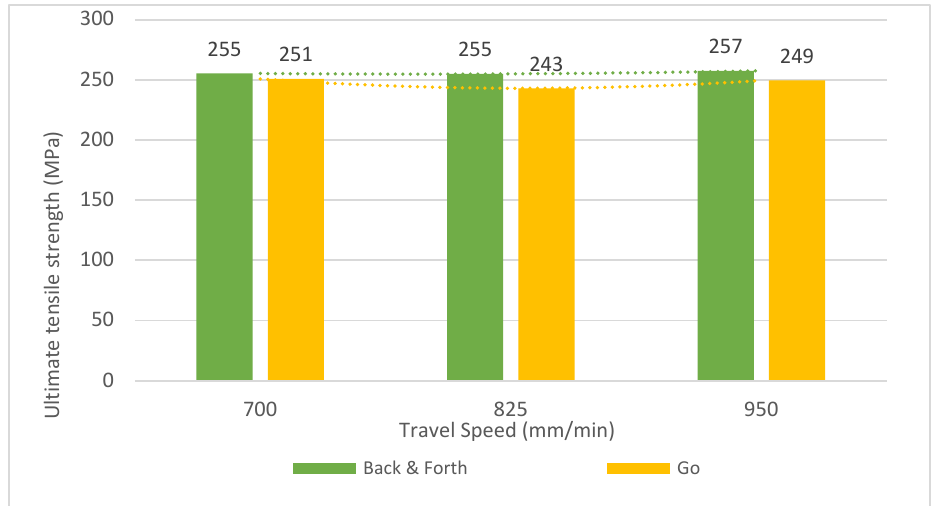
Figure 9. Ultimate tensile strength versus travel speed and path strategy. The relationship between maximum elongation and path strategy is shown in Figure 10. The strategy ‘Back and forth’ is better for increasing the maximum elongation, espe- cially when the cooling time was of 30 s.